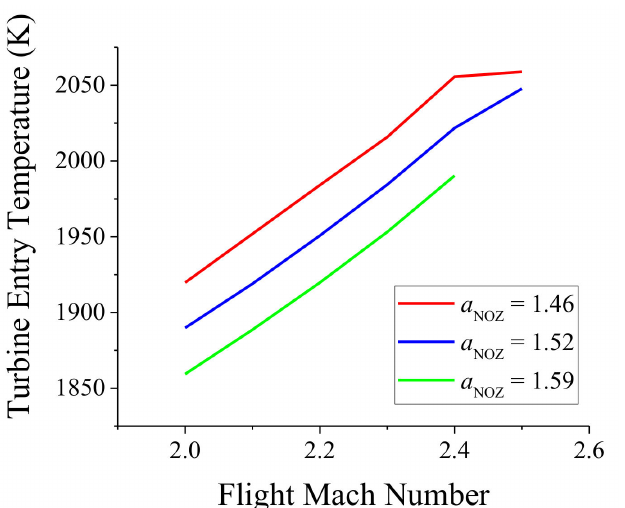
Figure 22. The Variations of Turbine Entry Temperature at the conditions of Different Throat Area Coefficients of Main Nozzle ( α NOZ